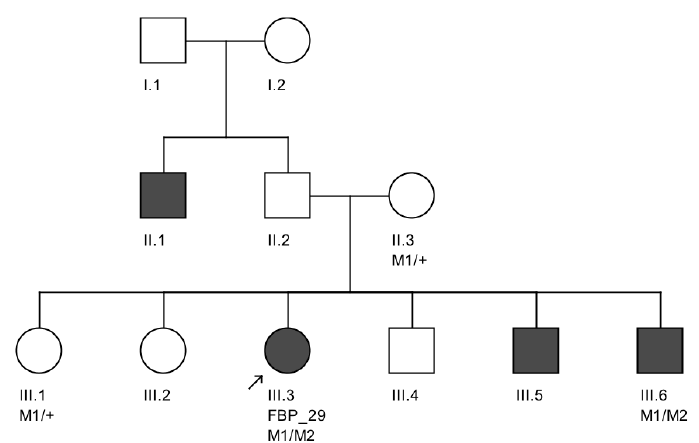
Figure 4. Variant segregation in the family of proband FBP_29. These CEP290 splicing variants M1 (c.6271-8 T>G) and M2 (c.C2991+1655A>G) segregated in trans in which M1 was maternally inherited. Both of the affected siblings that were available for segregation testing (III.3 and III.6) were verified to be heterozygous for each variant.